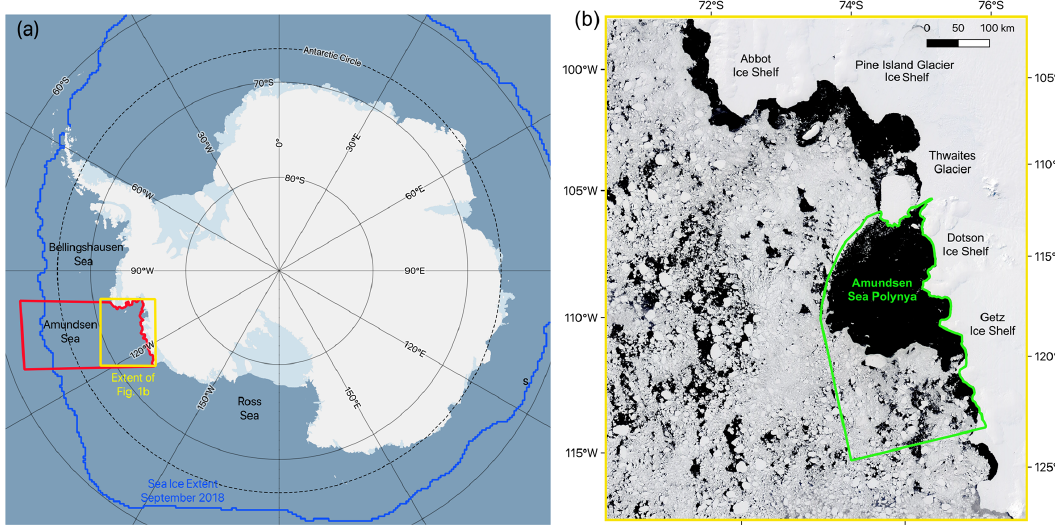
Figure 1. (a) The location of the Amundsen Sea and our study sites within the context of Antarctica and the Southern Ocean. The background image is from Quantarctica (Matsuoka et al., 2021); (b) the location of the ASP within the Amundsen Sea Embayment. The green boundary indicates the area defined as the ASP study area for the purpose of calculating the winter polynya area and ice production. The background image is a true-color MODIS image from 12 December